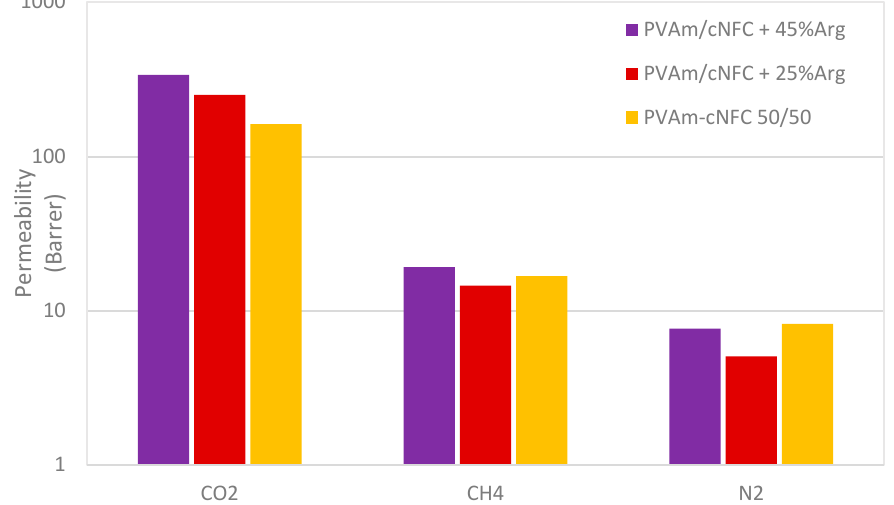
Figure 8. Permeability of methane, nitrogen and carbon dioxide in the different inspected mate-rials as obtained through Equation (3).